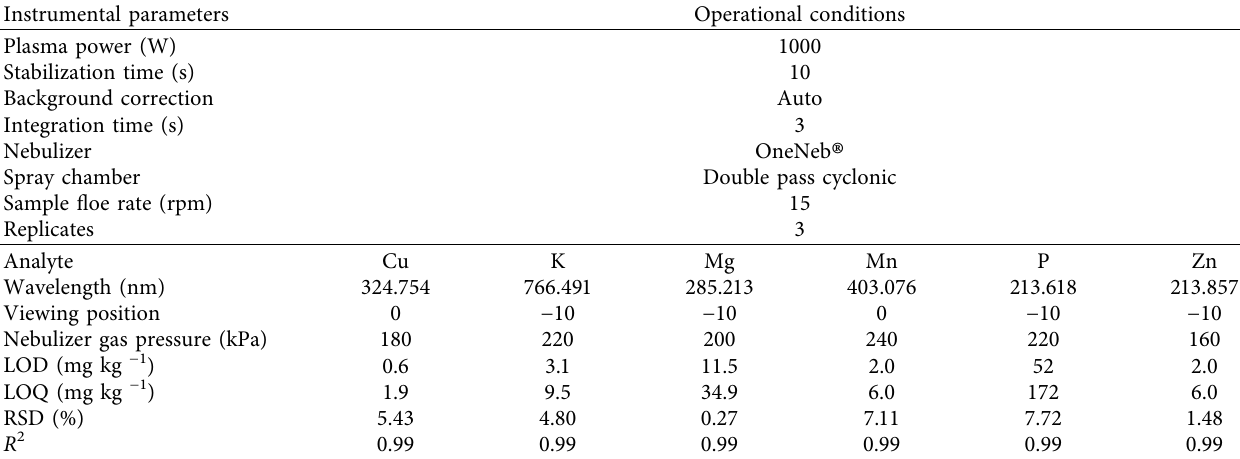
Table 1: Instrumental parameters and analytical figures of merits of the proposed UAE method by MIP OES. Instrumental